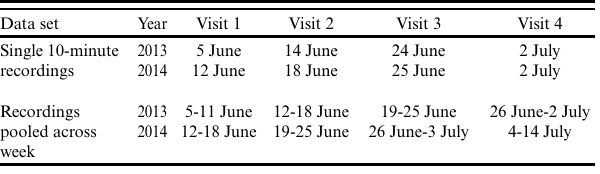
Table 3 . Sampling periods considered for the analysis of recording data collected from automated recording units deployed at 109 stations in Hearst Forest Sustainable Forest Licence, Ontario,